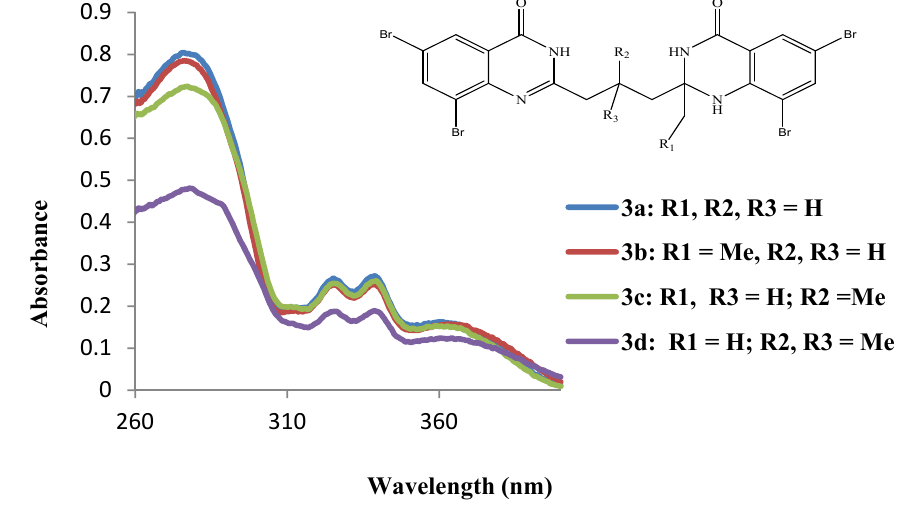
Table 1. The absorption data for compounds 3a – d